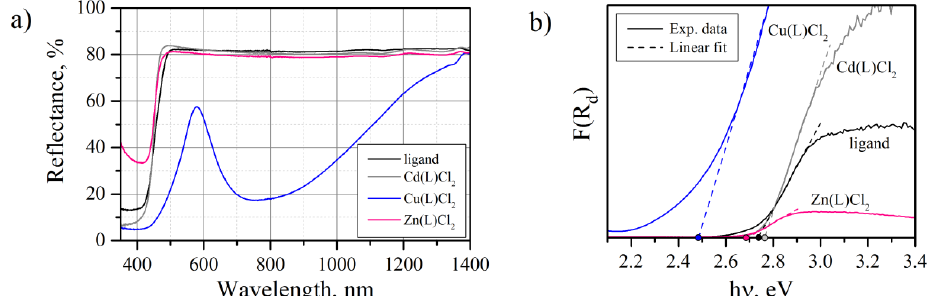
Figure 4. Diffuse reflectance spectra ( a ) and Kubelka – Munk plots for the optical bandgap energy calculation ( b ).